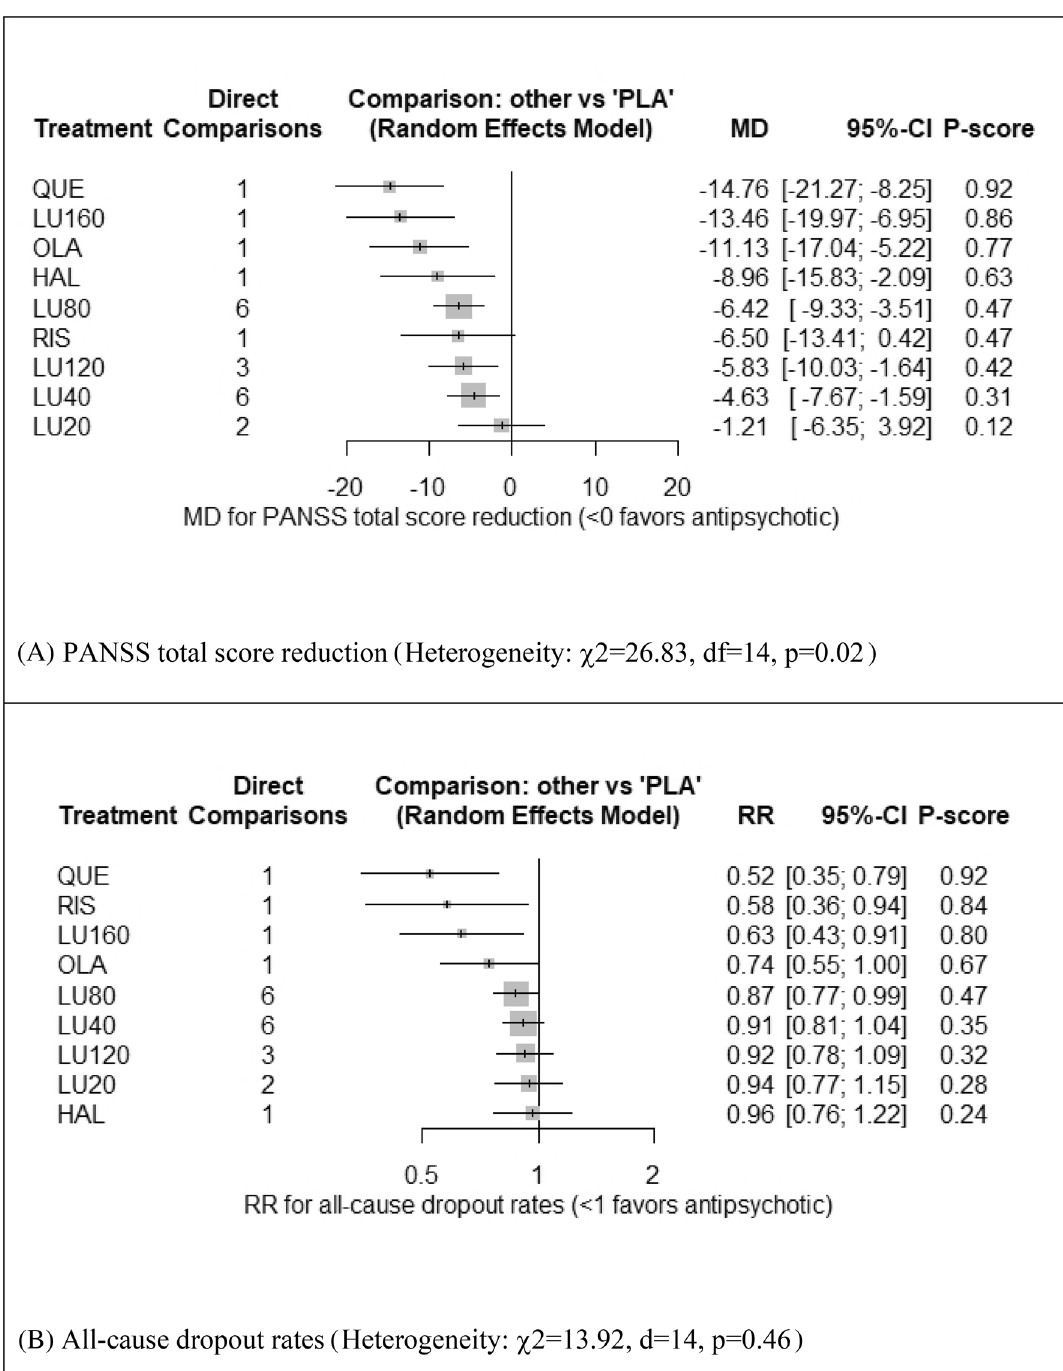
Figure 3. Forest plots: the efficacy and acceptability of lurasidone at different doses and other antipsychotics compared to placebo and the global heterogeneity (inconsistency) of data. MD: mean difference; RR: relative risk; P-score: p-value for treatment ranking. PANSS: Positive and Negative Syndrome Scale; LU20, LU40, LU80, LU120, LU160: Lurasidone 20, 40, 80, 120, 160 mg/day, respectively. HAL = haloperidol; OLA = olanzapine; PLA = placebo; QUE = quetiapine; and RIS =